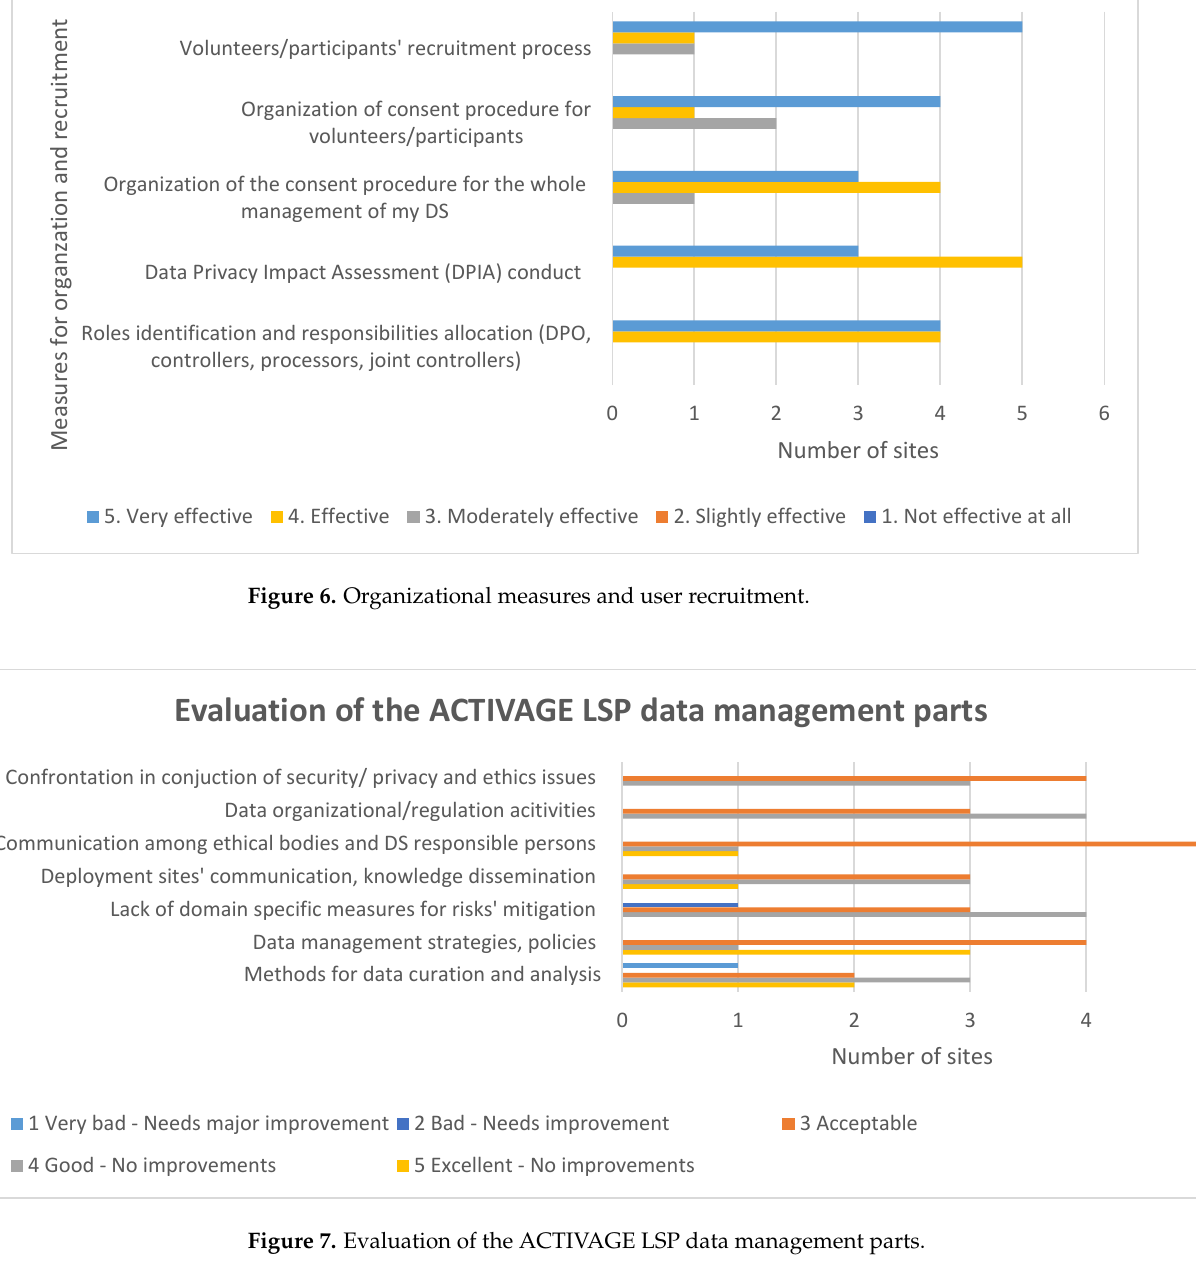
Figure 7. Evaluation of the ACTIVAGE LSP data management parts.